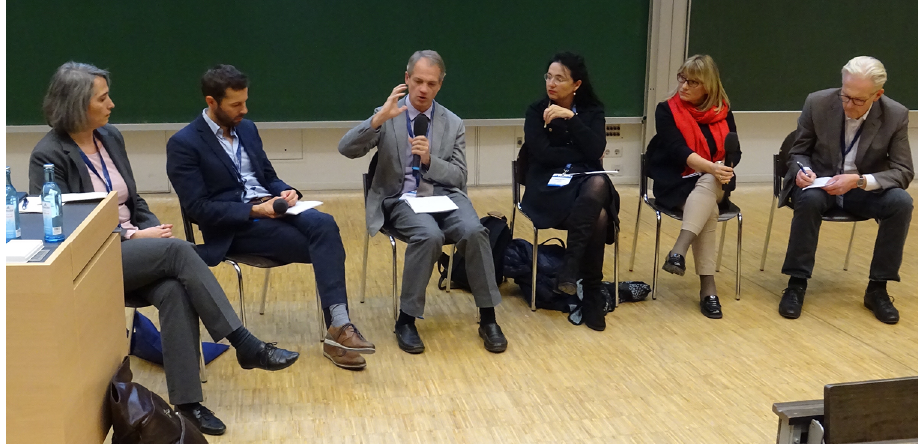
Figure 1. Panel Discussion "No health without mental health", Discussants: Tanja Endrass, Philipp Kanske, Stefan Hofmann, Claudi Bockting, Agnieszka Popiel, Martin grosse Holtforth. Photo and copyright by Michael Höfler, published under a CC-BY 4.0